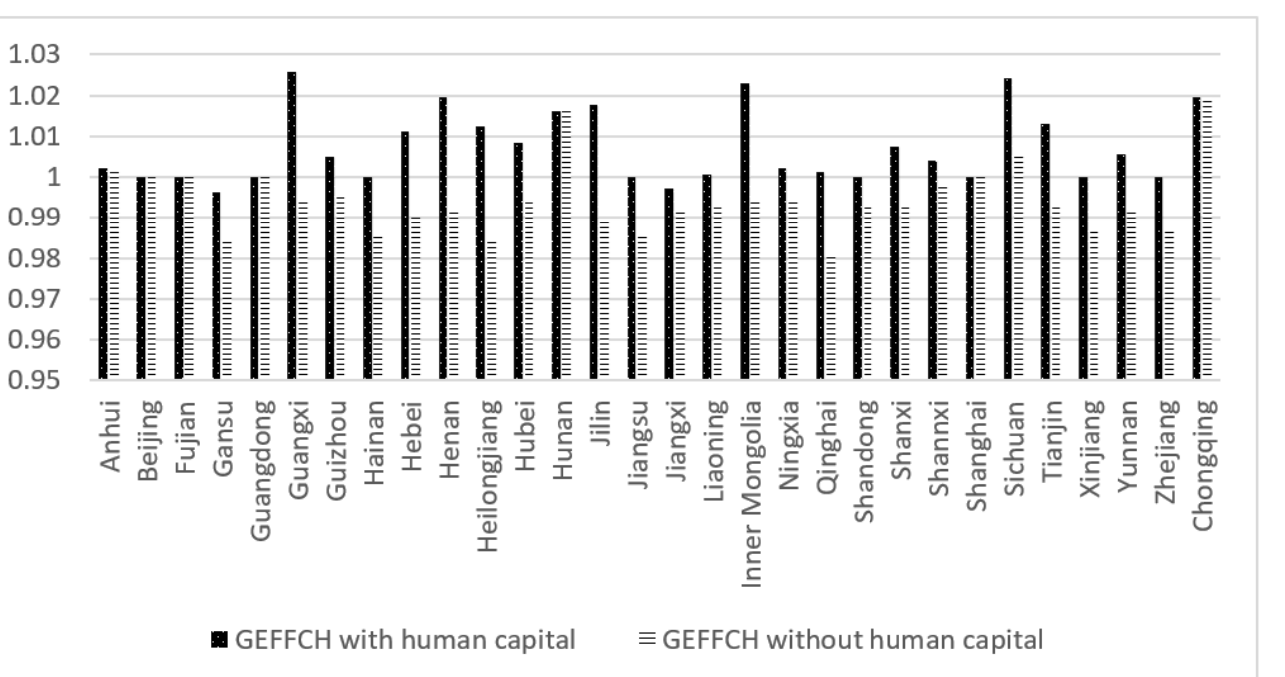
Figure 6. Comparison of technical efficiency among provinces and cities.